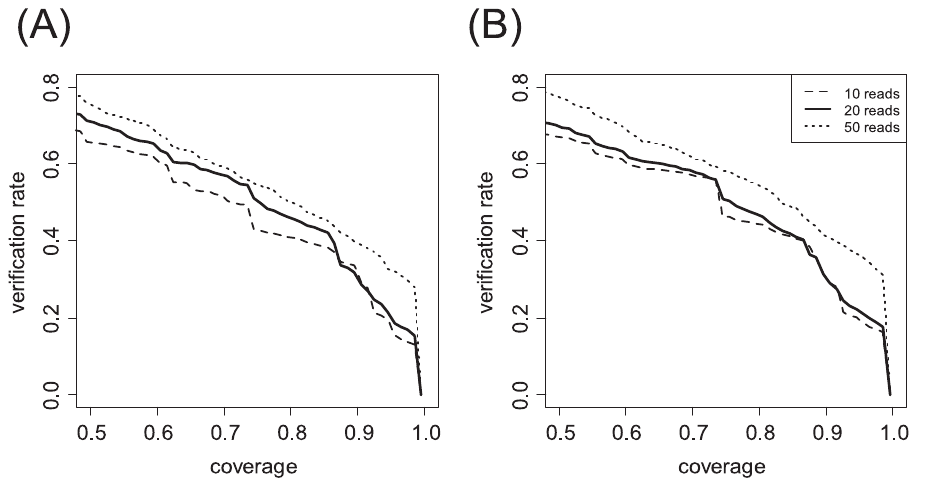
Figure 3. Verification rates in EST of new transcripts reconstructed from the data. The transcripts were reconstructed by using ( A ) RefSeq and ( B ) Ensembl as the reference databases. The solid line is the verification rate by transcript sequences in the EST database for the constructed transcripts supported by with more than 20 reads, the dashed line is with more than 10 reads, and the dotted line is with more than 50 sequencing